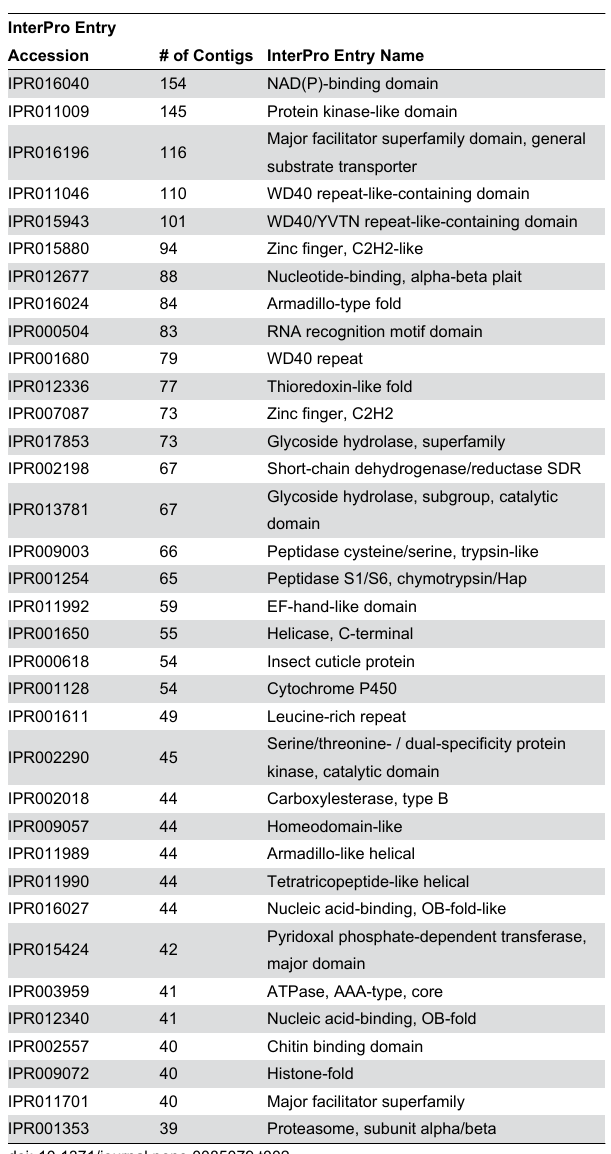
Table 2. Main protein families found in cotton boll weevil